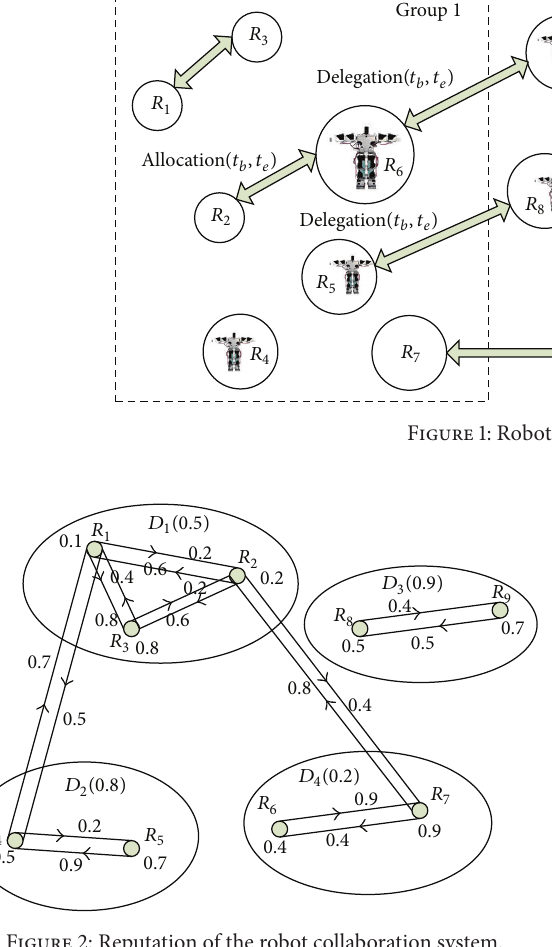
Figure 2: Reputation of the robot collaboration